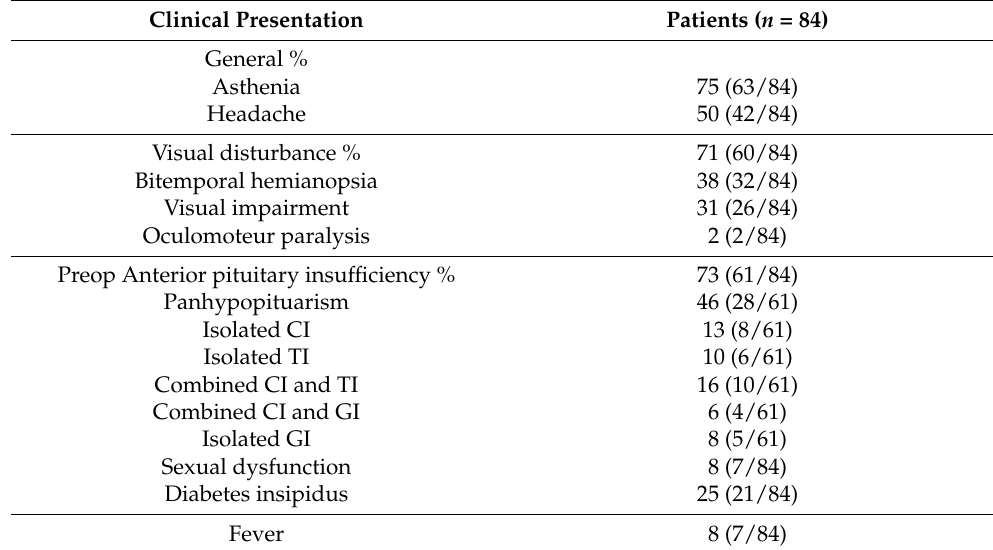
Table 2. PA patient series: clinical